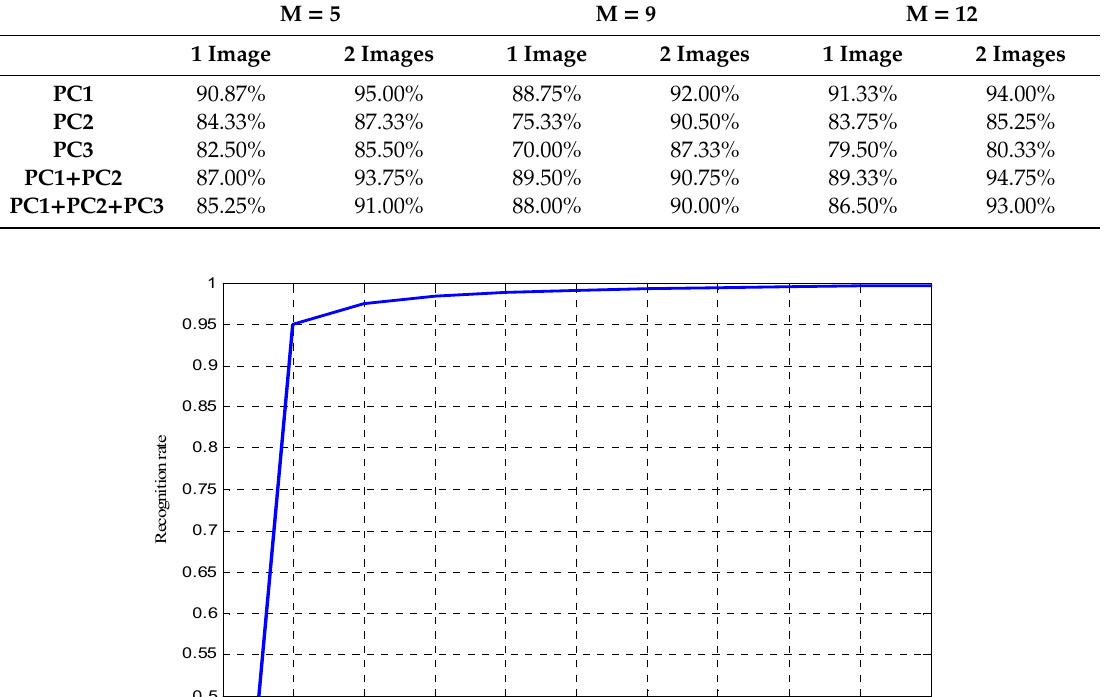
Table 4. Recognition rate of the face unimodal biometric system performed on the FERET face database.